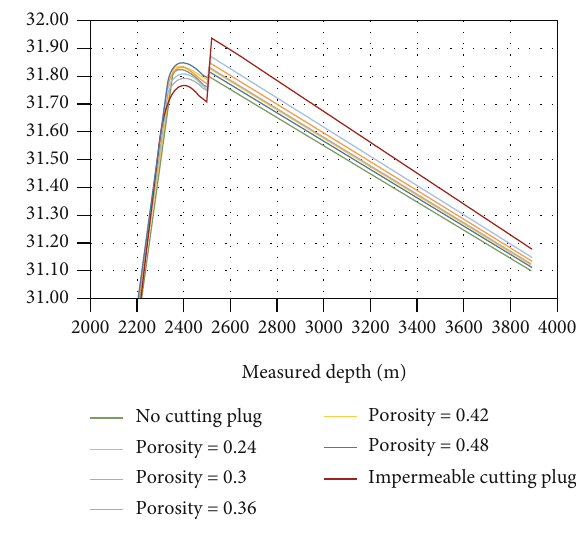
Figure 13: The e ff ect of cutting plug porosity on the wellbore pressures in an open pipe condition.